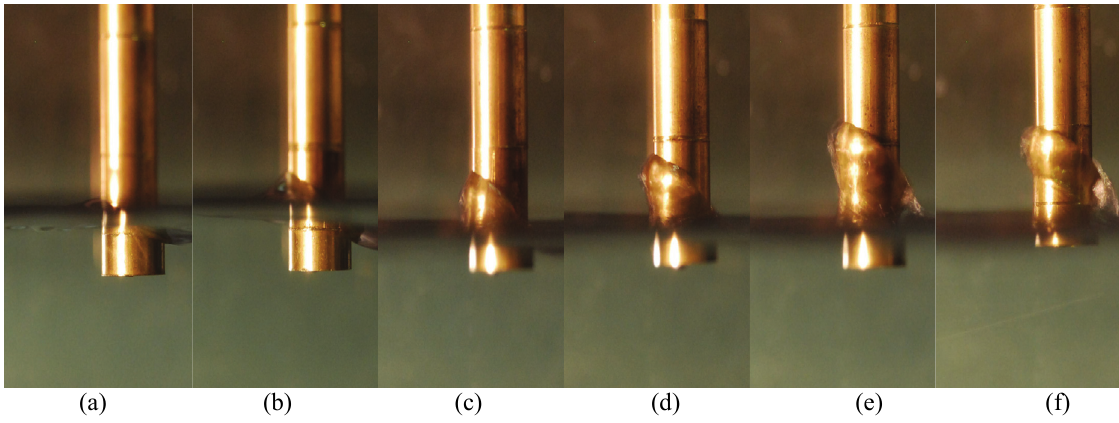
Fig. 5. The aspect of rising of the water surface, submerge depth is 5mm; (a) 0.33m/s, (b) 0.46m/s, (c) 0.59m/s, (d) 0.72m/s, (e) 0.85m/s, (f)